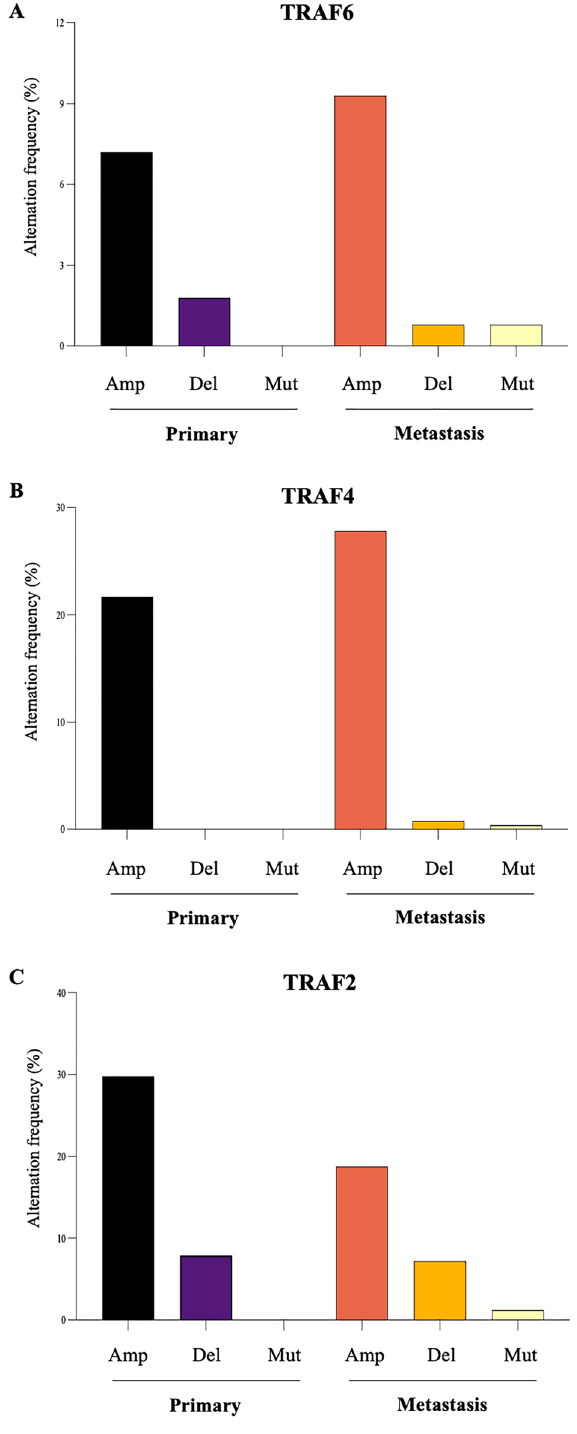
Figure 2. Genetic alterations in TRAFs in primary and metastatic breast cancer. Analysis of TRAF2 ( A ), TRAF4 ( B ) and TRAF6 ( C ) amplification (Amp), deletion (Del) and mutation (Mut) in tumours from patients of primary (n = 166) and metastatic (n = 335) breast cancer from the Metastatic Breast Cancer Project reported in the cBioPortal (https:// www. cbiop ortal.